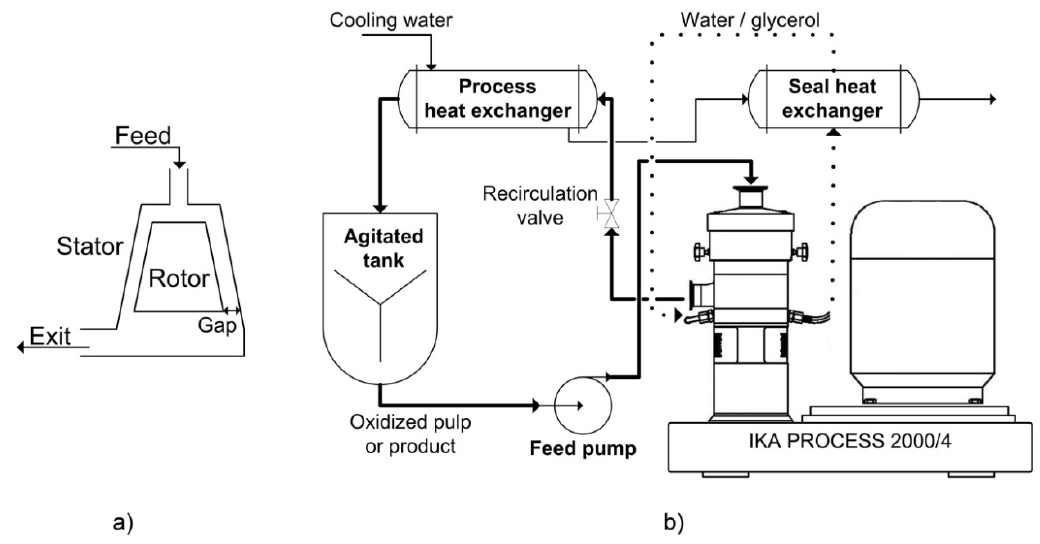
Figure 9. ( a ) Schematic representation of the operation principle; ( b ) Schematic diagram of the colloid milling apparatus (MK 2000/4) from Process IKA Works,